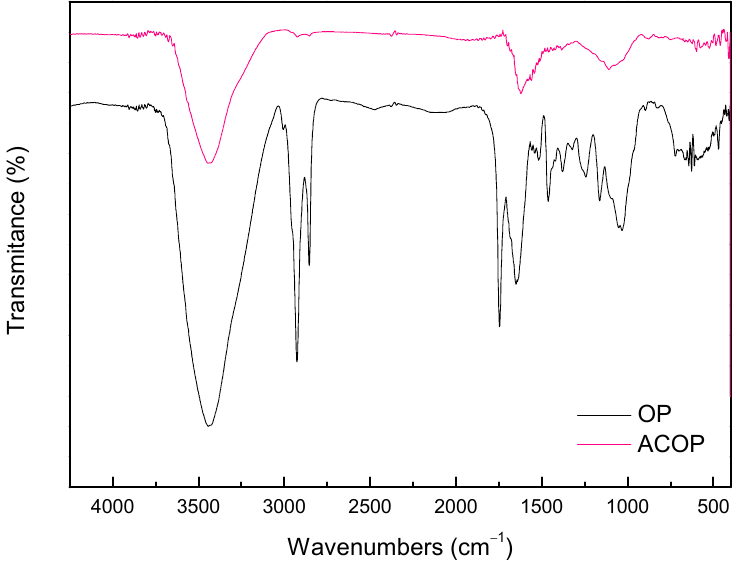
Figure 3. FTIR vibrational spectra of OP and ACOP.